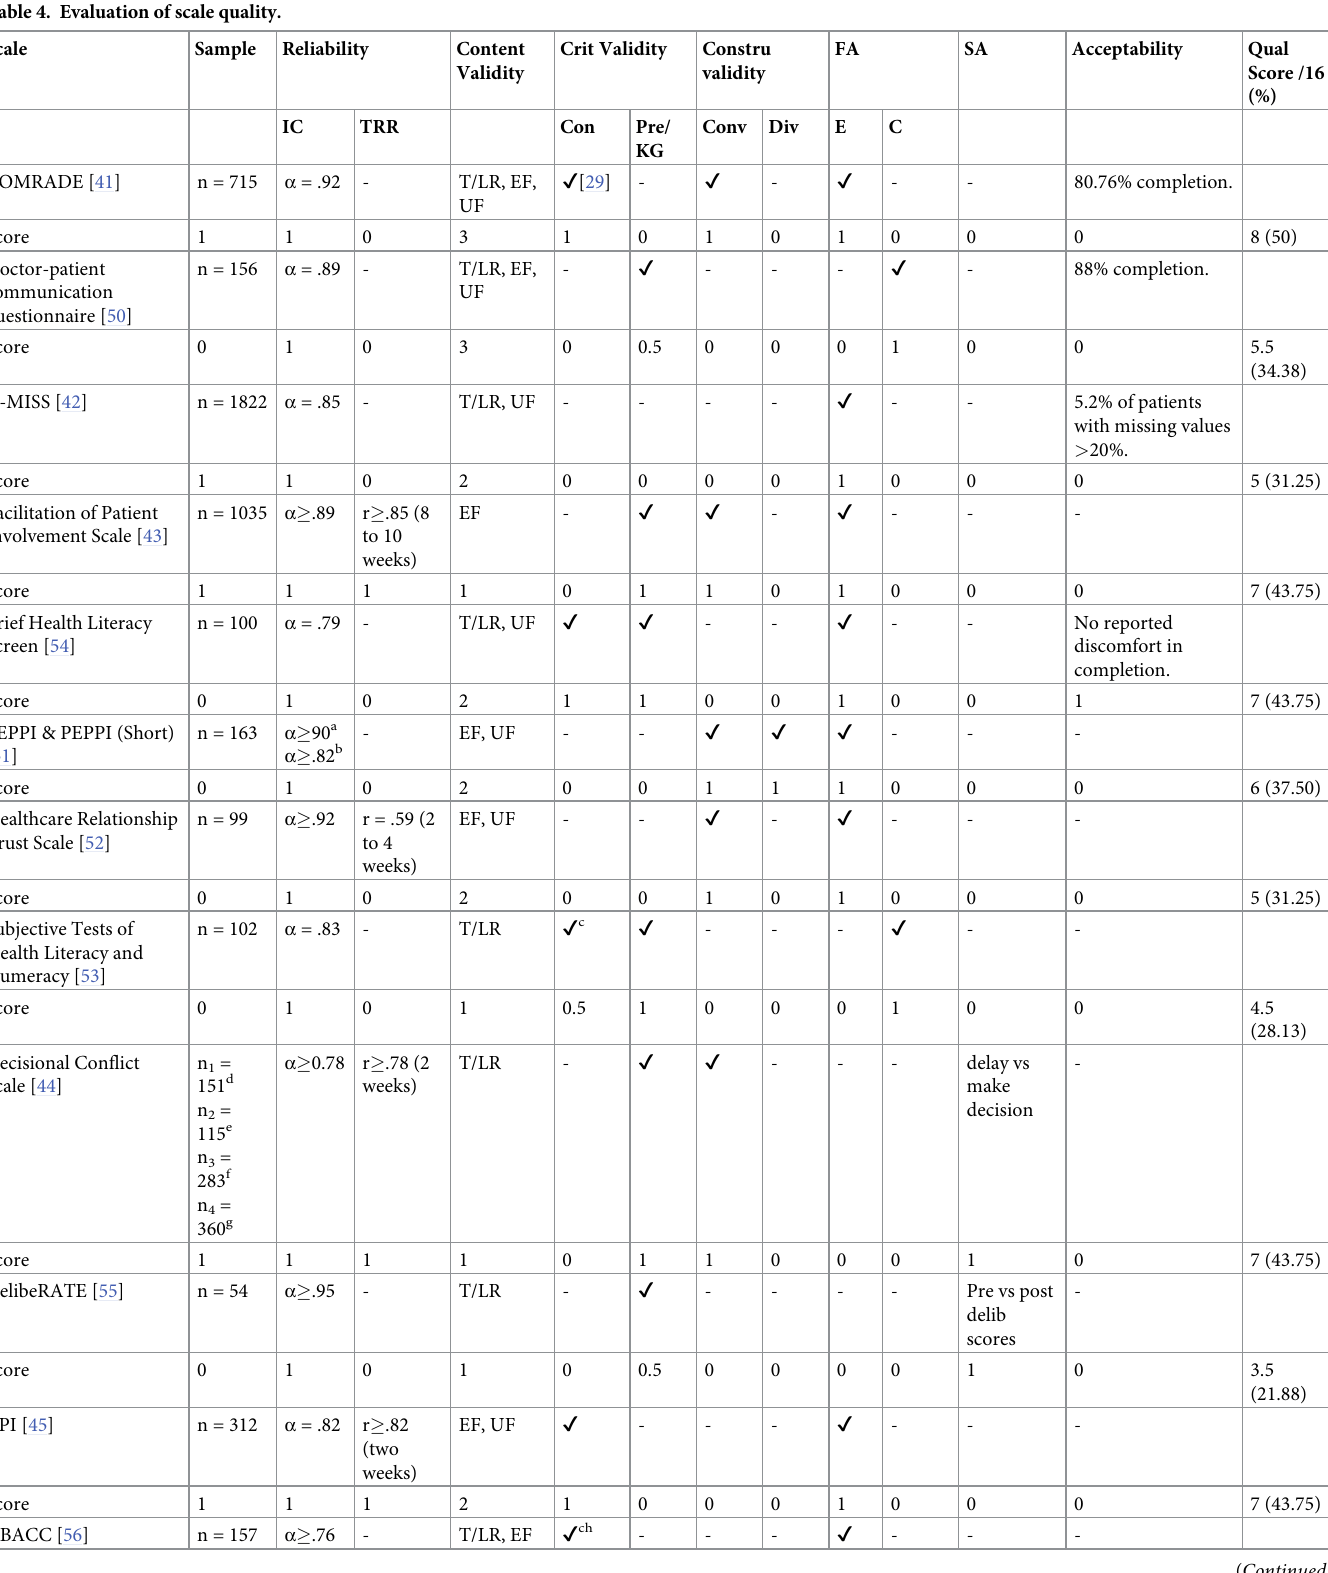
Table 4. Evaluation of scale